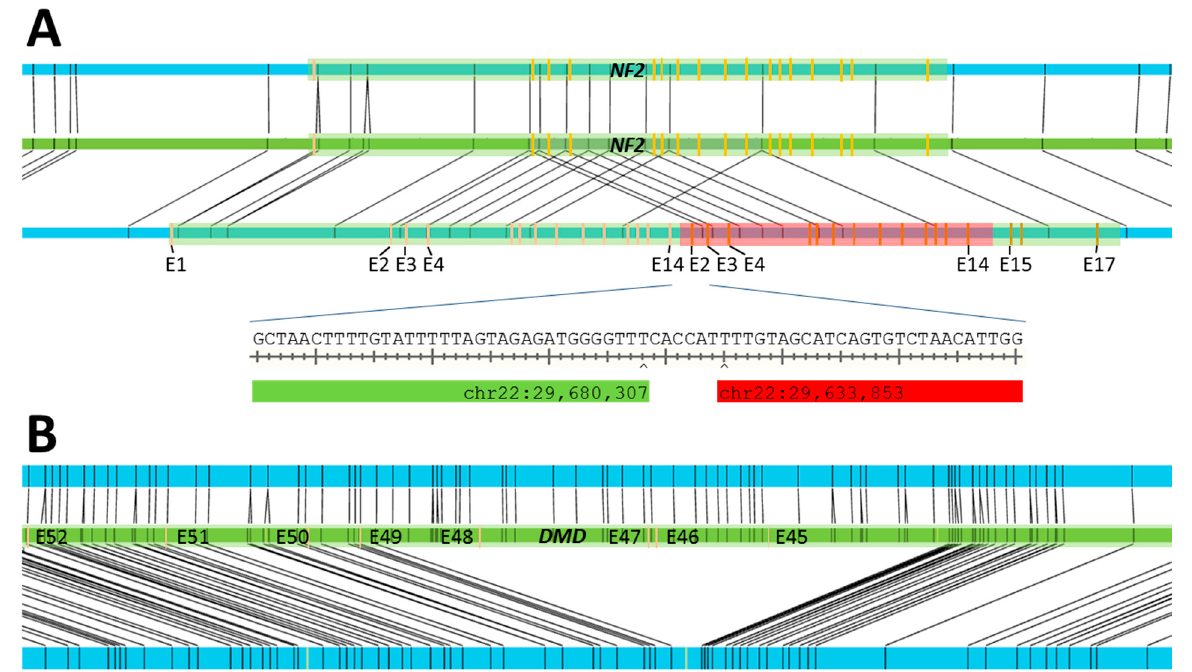
Figure 5. Schematic representation of small-scale SVs. ( A ): The green tracks show the reference genome ChGR38 at the position of the NF2 gene of S12, with the gene itself shown as green widening of the track. Its exons are marked in orange. The OGM labels are marked in black. The blue tracks above and below the reference track show the two OGM maps covering the region and representing the two alleles present. They are likewise marked with the exons of NF2 and the OGM labels. OGM labels aligned between a map and the reference track are depicted as black lines connecting them. The map above the reference track shows the normal allele, whereas the map below contains a tandem duplication. The duplicated portion of the reference is indicated by the alignment of each of its labels with two labels of the map. The duplicated portion of the NF2 gene is situated between exons 14 and 15, thereby disrupting the gene (highlighted in red). The exact location of the breakpoint between exons 14 and 2, as determined by sequencing, is depicted below. ( B ): The deletion of several exons of the DMD gene of S13, shown using the same scheme as in ( A ).